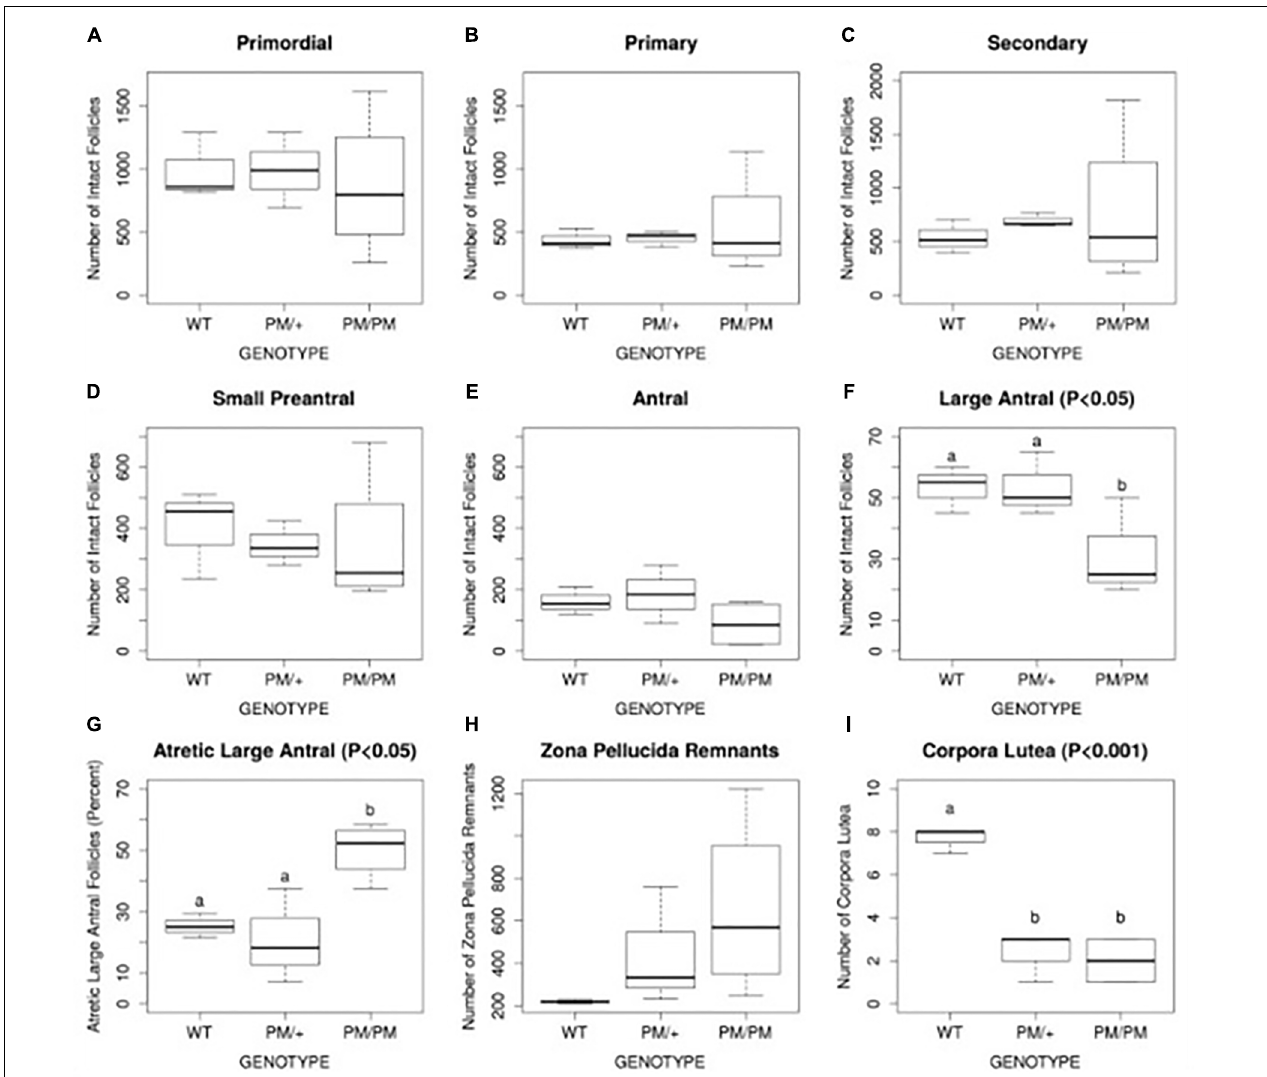
FIGURE 1 | Histomorphometric analysis of follicle number, atresia, and corpus luteum number of 8 month old FXPM mutants and wild type control animals. Quantification of intact primordial, primary, secondary, pre-antral, and large antral/periovulatory follicles per ovary ( n = 4 per genotype) is shown in A–F . Follicle atresia was evaluated by counting atretic large antral follicles (G) and zona pellucida remnants (ZPR, H ). Corpus luteum (CL) number is shown in (I) . Note increased variability in the number of PM/PM follicles, ZPR, and CL. Statistically different means, where applicable, are denoted by letters “a” and “b,” with P -values shown above each plot as calculated by ANOVA analysis. Conca Dioguardi et al.